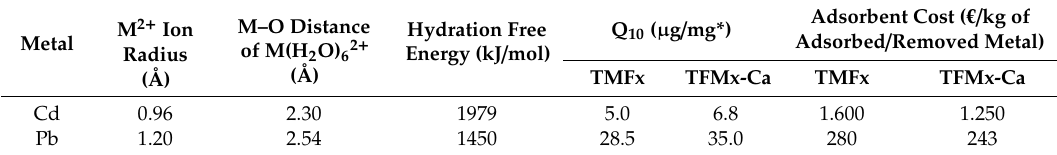
Figure 7. RSSCT breakthrough curves for the removal of Cd and Pb from water by adsorption, when using the NSF water matrix and for the pH value 7.2 ± 0.1. Table 4. Physicochemical characteristics of Cd and Pb related to the adsorption capacities of TMFx and TMFx-Ca materials and the respective adsorbent costs